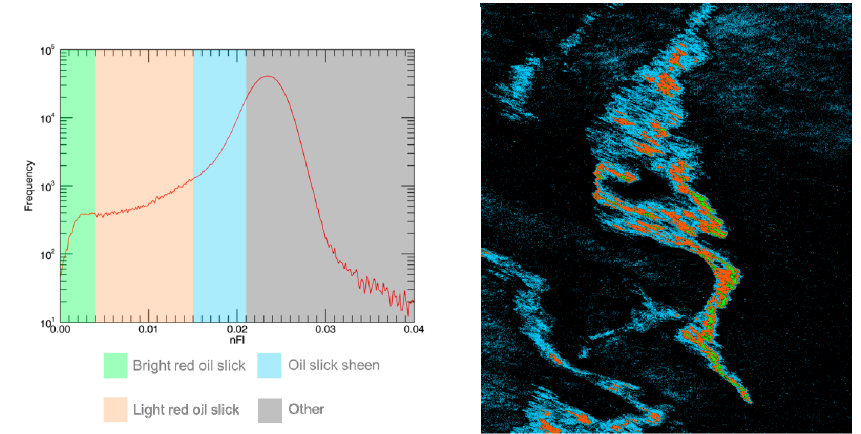
Figure 12. ( Left ) Histogram of the nFI score map with the four colored groups according to different nFI value ranges. ( Right ) Image in which each pixel is affected to the color corresponding to its nFI score group.